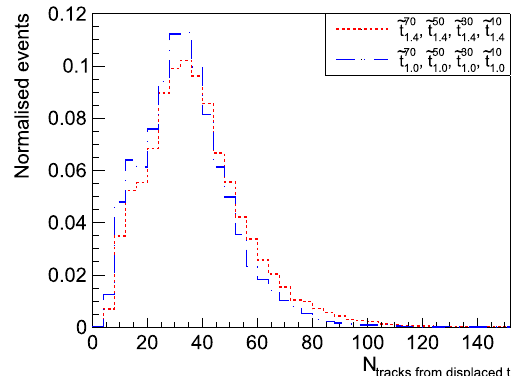
Fig. 47 α T distributions in the stop squark ˜ t case Fig. 49 Multiplicity of tracks generated by the long-lived particle for the eight benchmarks in the stop squark ˜ t case distance values). The choice of the flight distance parameter also leads to a different multiplicity of displaced top quark signatures in the same event: two, one or zero. The fraction The MET in the prompt-top background (which only comes of events corresponding to each configuration is displayed in from the neutrinos) is relatively small (around 40 GeV, see (cid:4) = 10 cm case, more than 90% Table 6). The leptons coming from the decay of the W bosons Table 6. Except for the (cid:3) d flight ˜ t of the events have at least one stop squark decaying inside also get a high transverse momentum with mean value of 105 = 1 . 0 and 1 . 4 TeV, the tracker volume. and 135 GeV for m ˜ t